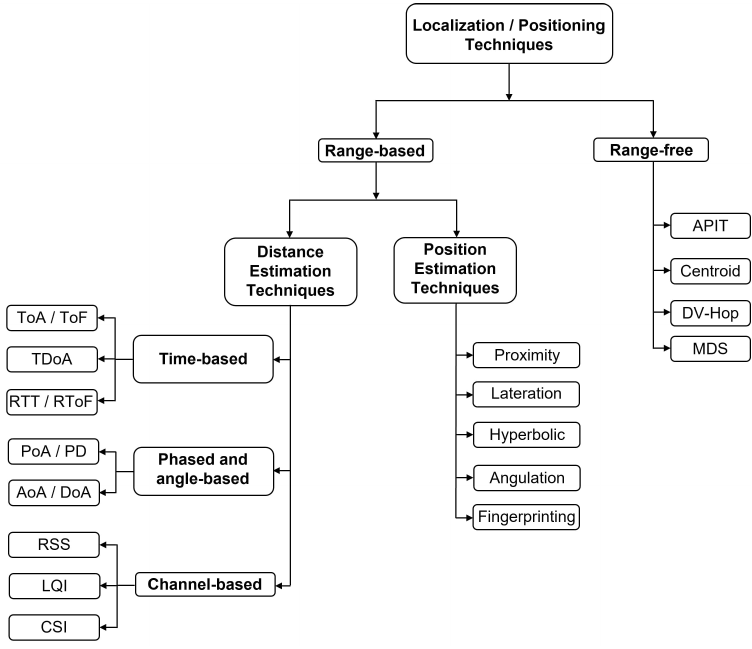
Figure 1. Localization/Positioning Techniques